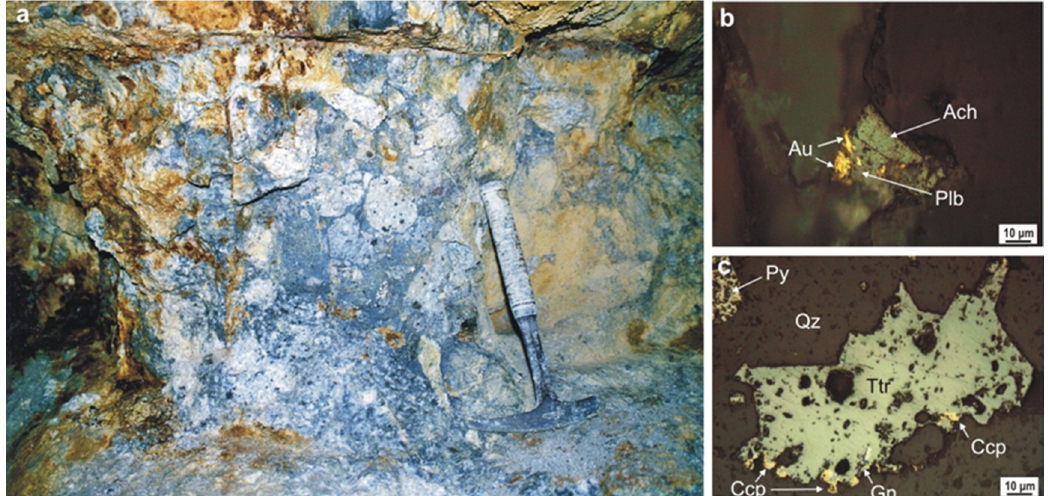
Figure 3. Underground view ( a ), and microphotographs in plane polarized light ( b , c ) of the ore body corresponding to sample 1551, the Roman mining network Cârnic 10, Lower sector: ( a ) partial view of a face line of the Roman stope with the hydrothermal breccia ore body with rounded to sub-angular rock fragments (mainly dacite) and black cement; ( b ) native gold associated to acanthite and polybasite deposited in a void of the hydrothermal cement; and ( c ) tetrahedrite grain associated to galena, chalcopyrite, and an isolated pyrite crystal. Ach: acanthite; Au: native gold; Ccp: chalcopyrite; Gn: galena; Plb: polybasite; Py: pyrite; Qz: quartz; and Ttr: tetrahedrite. Minerals 2021 , 11 , x FOR PEER REVIEW